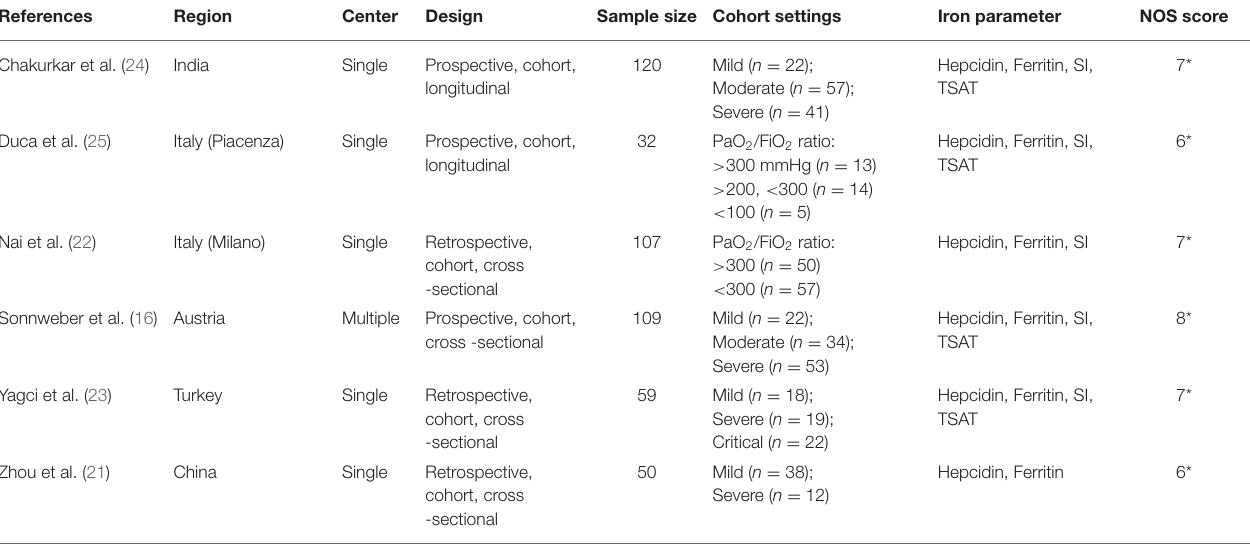
TABLE 1 | Detailed characteristics of the eligible